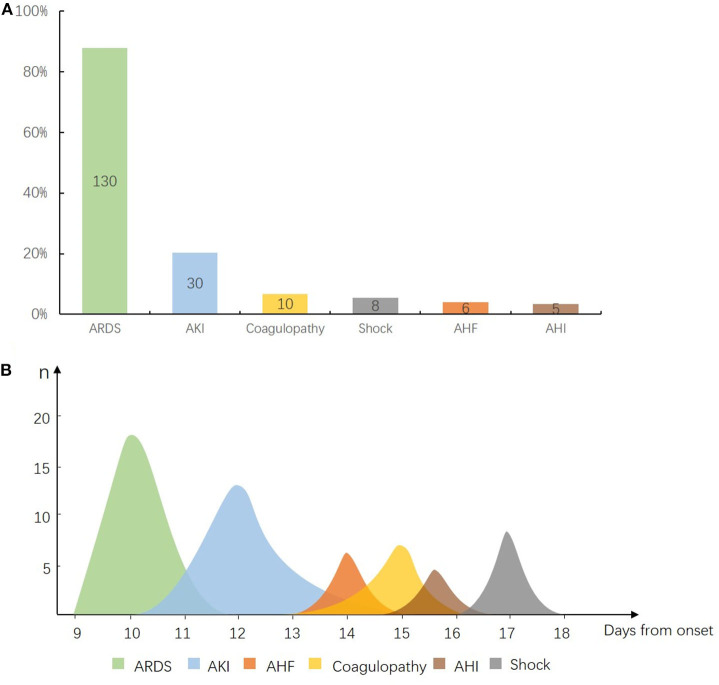
Sequential organ injury in deteriorated coronavirus disease 2019 (COVID-19) patients. (A) Composition of organ dysfunction in 148 deteriorated patients. X axis for each kind of organ injury and Y axis for the ratio of patients who developed each kind of organ injury. Out of 148 cases, 87.8% (n = 130) of acute respiratory distress syndrome (ARDS), 20.2% (n = 30) of acute kidney injury (AKI), 6.8% (n = 10) of coagulopathy, 4% (n = 6) of acute heart failure (AHF), 3.4% (n = 5) of acute hepatic injury (AHI), and 5.4% (n = 8) of shock. (B) Time windows for occurrence of organ injury in 18 critical patients. X axis for time from symptom onset to start of each kind of organ injury and Y axis for the number of patients who developed organ injury of each kind. ARDS occurred on day 10 [interquartile range (IQR) 9–12] from onset, AKI (n = 15) on day 12 (IQR 10–15), AHF (n = 6) on day 14 (IQR 13–15), coagulopathy (n = 7) on day 15 (IQR 13–16), AHI (n = 4) on day 15.5 (IQR 15–17), and shock (n = 8) on day 17 (IQR 16–18).